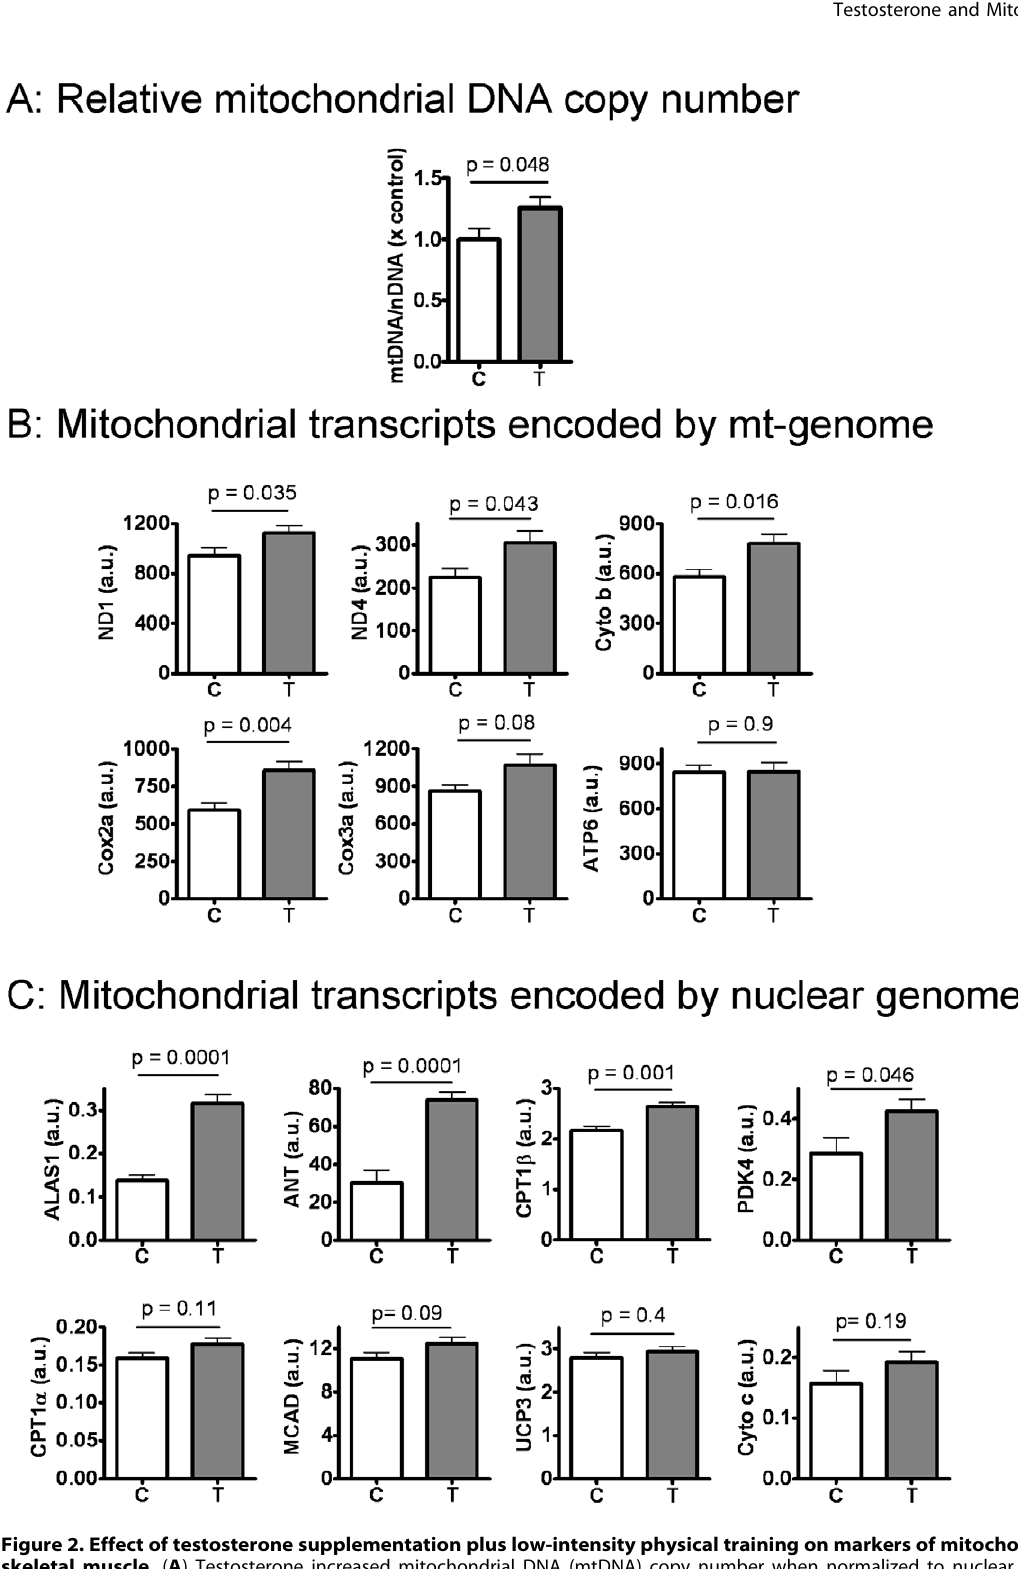
PLOS ONE | www.plosone.org